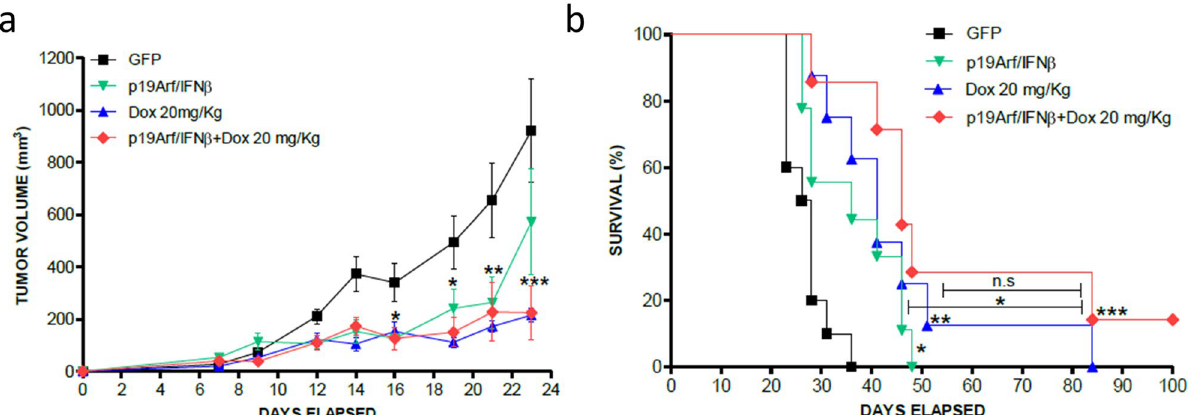
Figure 5. In vivo association of p19Arf/IFNβ gene therapy with doxorubicin inhibits tumor progression and changes the dynamic of caspase 3 activity. ( a ) Tumor progression curves of established MCA-DEVD tumors that received in situ gene therapy with the AdRGD-PG-p19 and AdRGD-PG-IFNβ vectors and after 48 h, treated with 20 mg/kg of doxorubicin as indicated. [Two-way Anova and Bonferroni post-test] n = 6 for all groups. ( b ) Survival analysis of mice from a . [Log Rank Mantel-cox test, followed by Wilcoxon post- Test. n = 8 for all groups, except p19Arf/IFNβ which n =